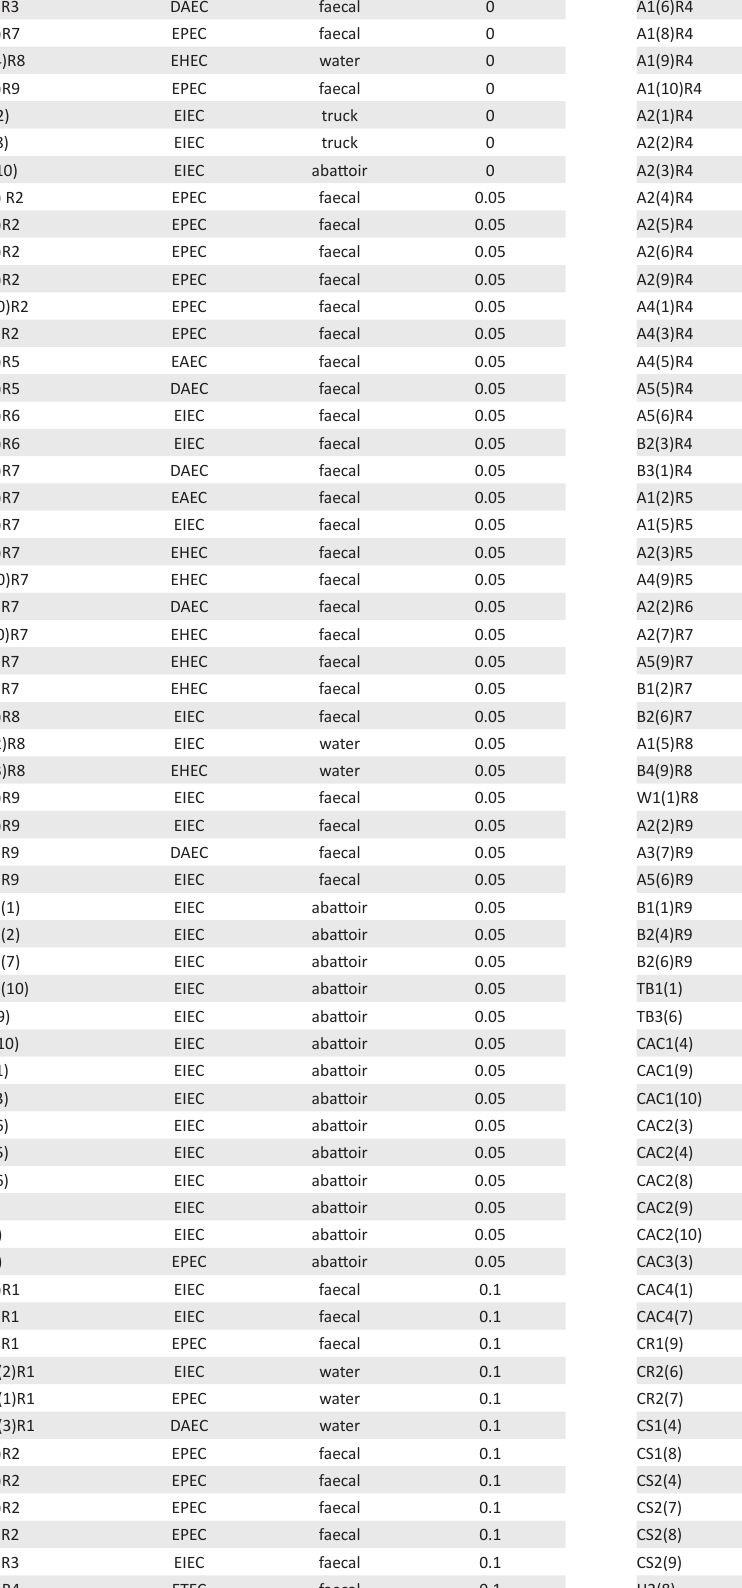
TABLE 4-A1: Multiple-antibiotic resistance index for all diarrheagenic E. coli pathotypes along the farm-to-fork continuum. Bacterial ID